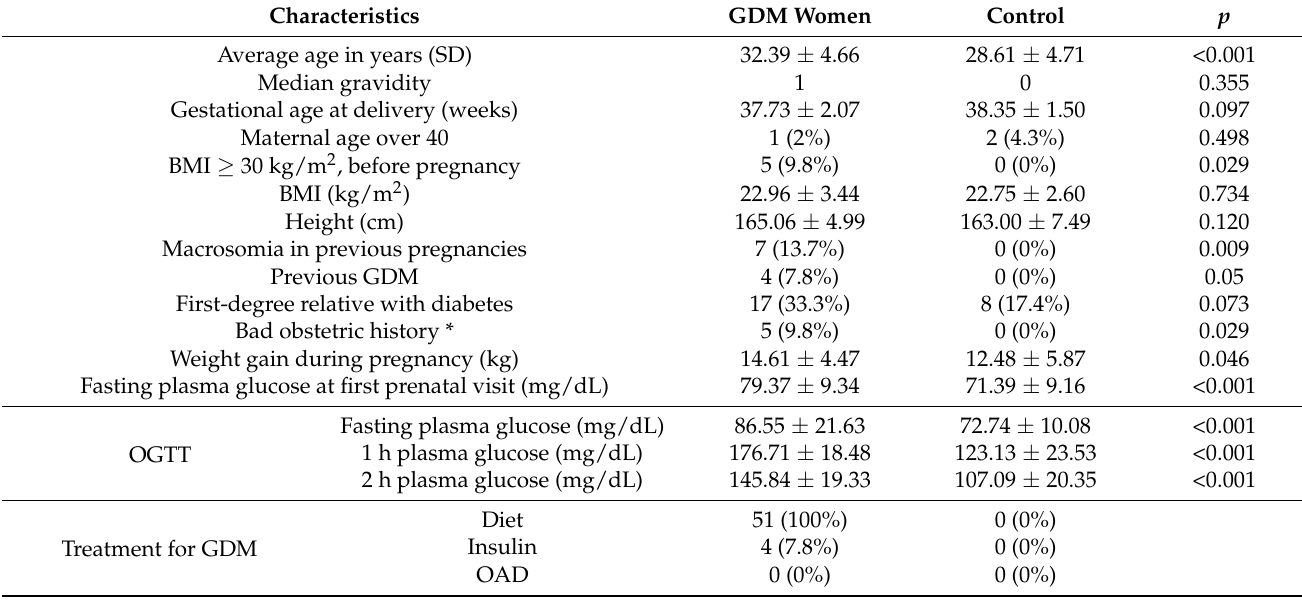
Table 2. Clinical characteristics of the women with GDM and control